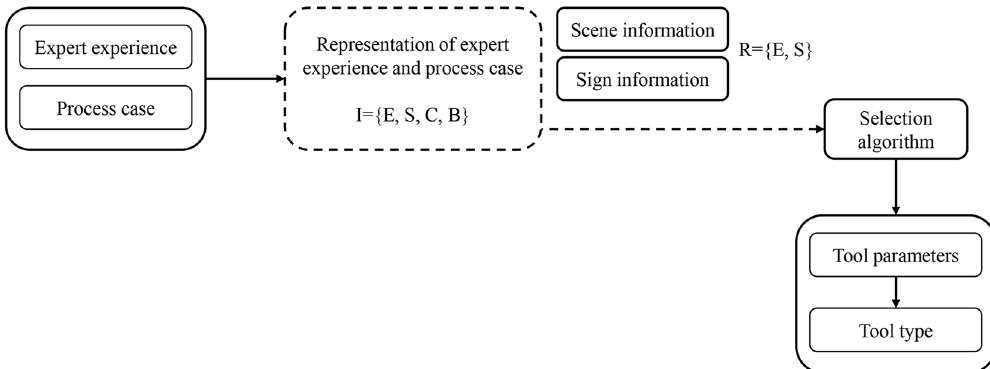
Figure 1. The selection principle of